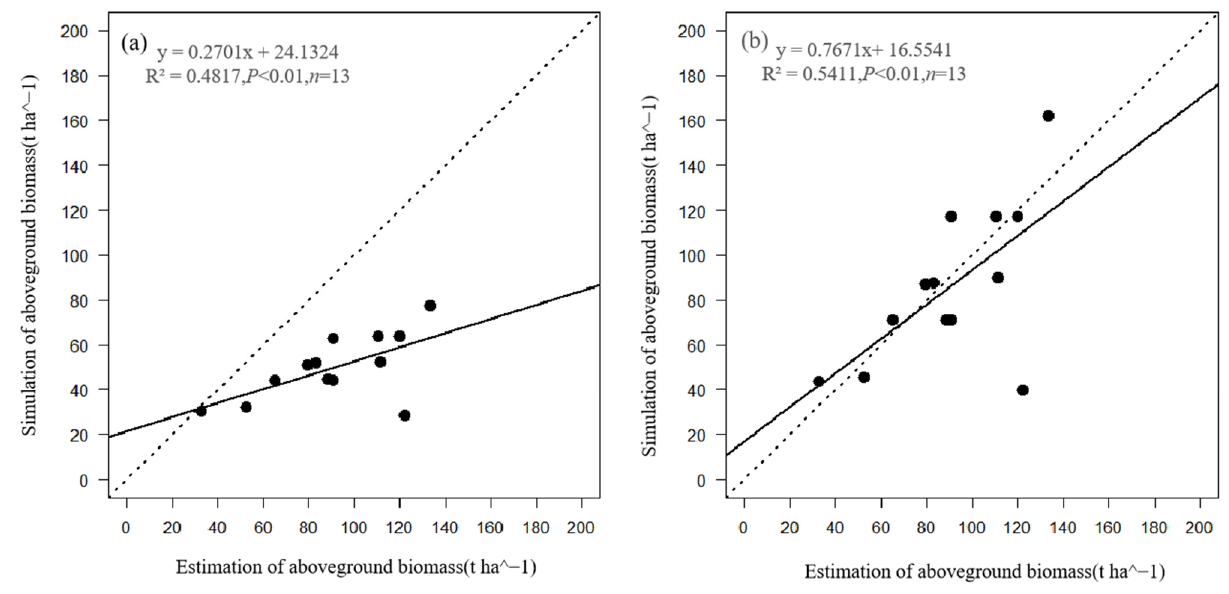
Figure 2. Comparisons between simulations for the original model ( a ) and modified model ( b ), and the estimated aboveground biomass (t ha − 1 ), respectively, for 10 poplar stands with different stand densities in northern Jiangsu Province. The solid line represents the fitting line, and the diagonal line represents the 1:1 line.